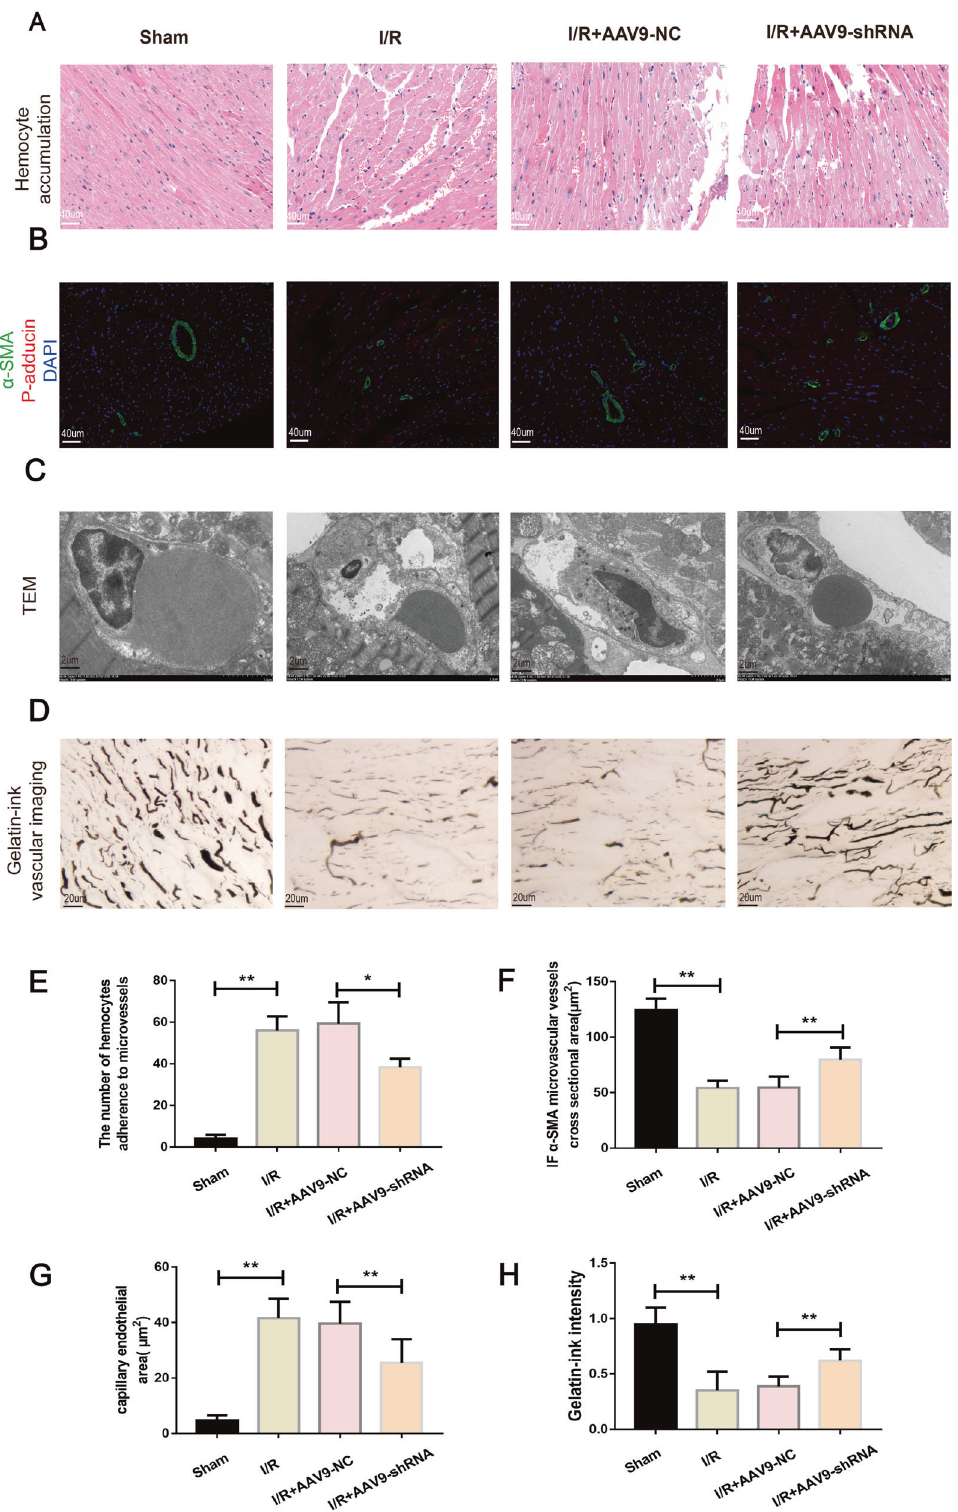
Fig. 7 mmu_circ_0000021 suppression improved cardiac microvascular perfusion following I/R. A , E After a microvascular blockage, HE staining revealed erythrocyte aggregation and morphological alterations. B , F Immuno fl uorescence detection of α -SMA in microvessels. C , G Microvascular endothelial and luminal areas were assessed using TEM. mmu_circ_0000021 suppression reduced I/R-induced endothelial cell edema and hypertrophy, which resulted in luminal stenosis. D , H Microvascular perfusion was examined using gelatin-ink staining. When I/R was suppressed, mmu_circ_0000021 suppression reduced the microvessel obstruction. * P < 0.05, ** P < 0.01, vs. indicated group; n = 8/ group.